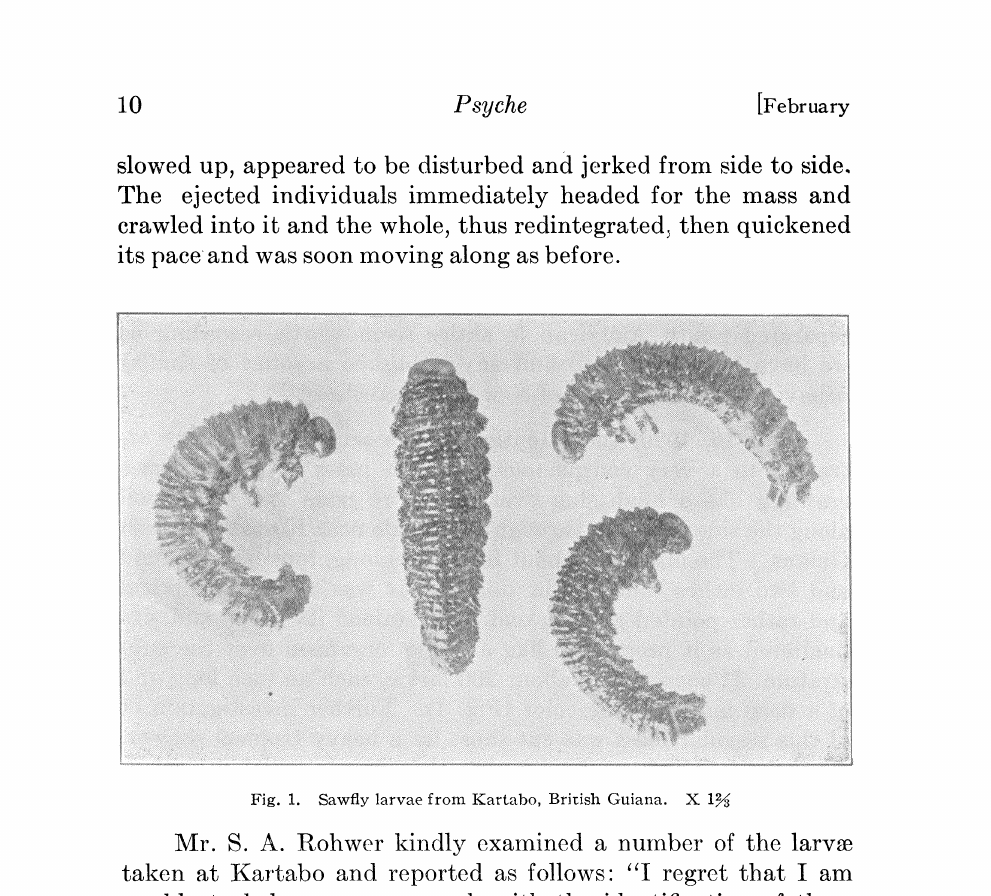
Fig. 1. Sawfly larvae from Kartabo, British Guiana. X